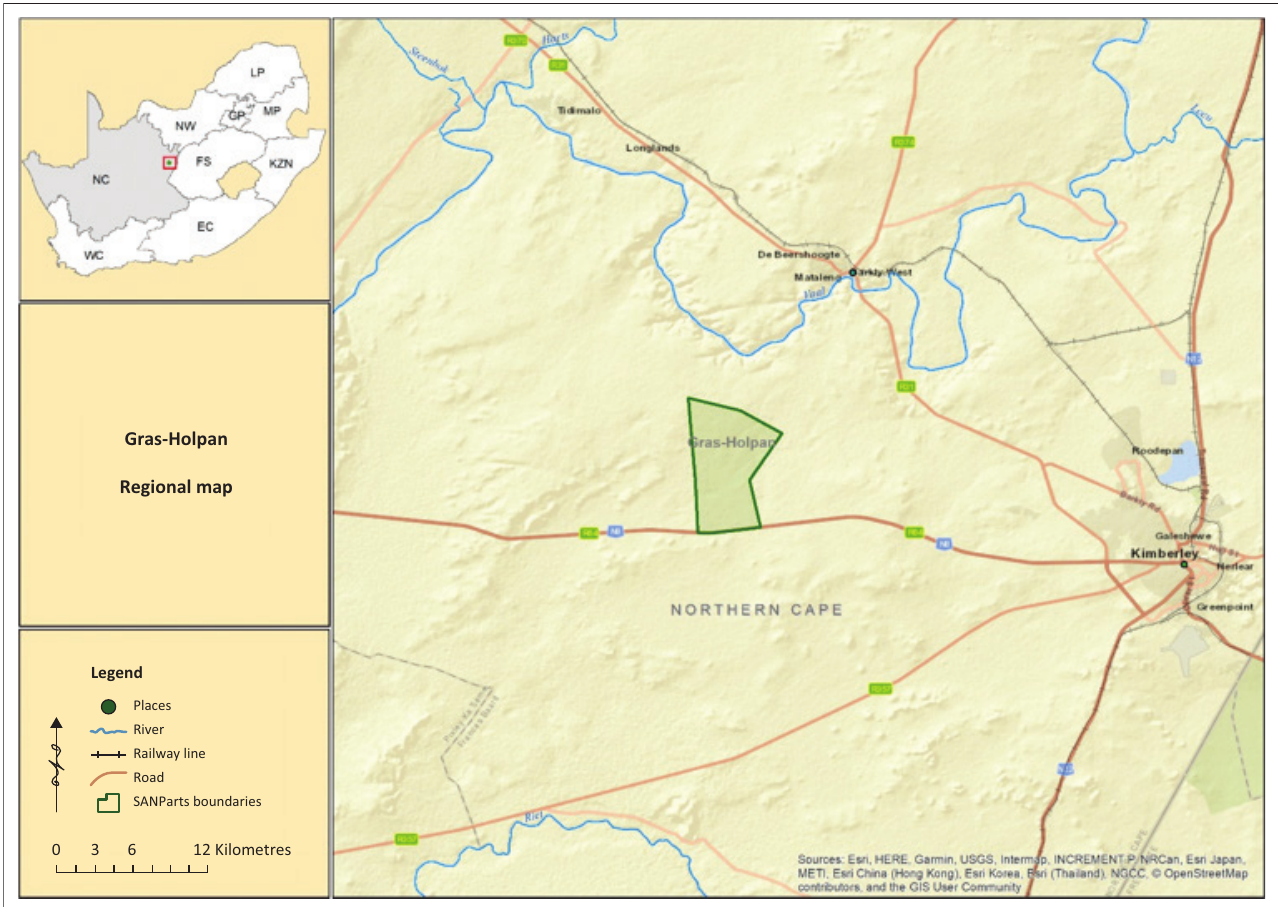
FIGURE 1: Location of Gras-Holpan, Northern Cape, South